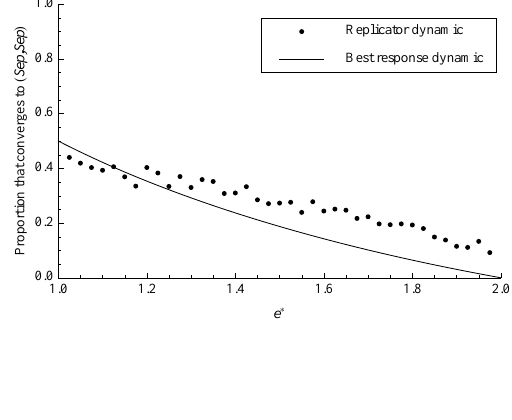
Figure 4. The proportion of phase space that converges to separating under both dynamics = . 5 . Each data point for the replicator dynamic is the average of 1000 randomly with p H chosen initial